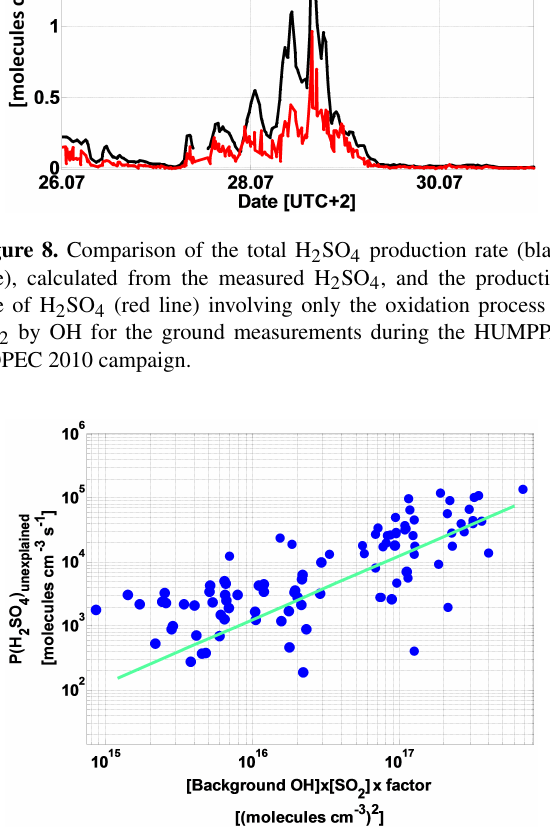
Figure 9. The production rate of H 2 SO 4 unaccounted for by the ox- idation of SO 2 by OH as a function of the OH bg multiplied by SO 2 concentration during the ground measurements of the HUMPPA- COPEC 2010 campaign. OH bg is expressed in moleculescm − 3 equivalents of